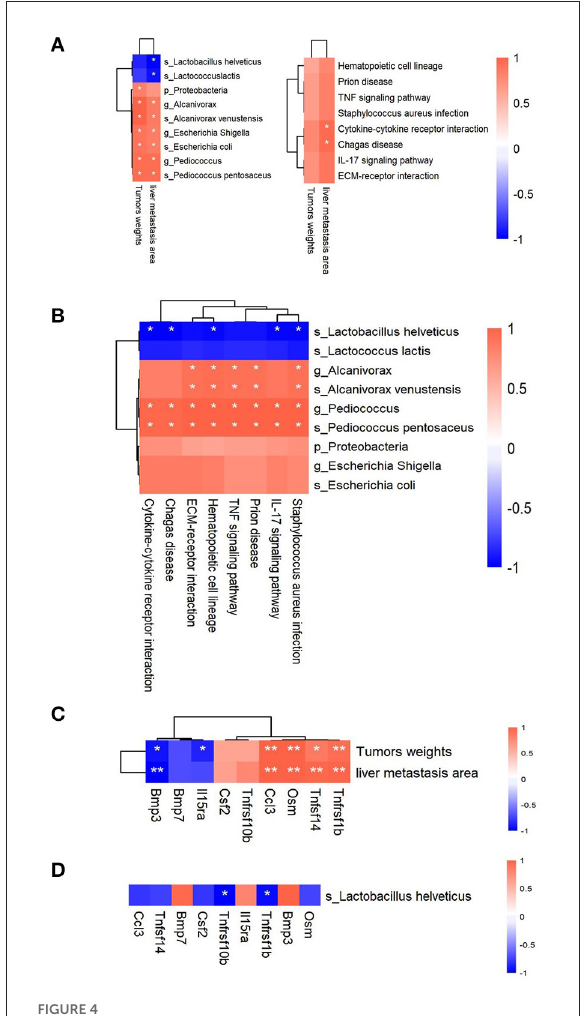
FIGURE4 Correlations among the gut bacteria, signaling pathways, DEGs, and tumor-related parameters. (A) Heatmaps of the Spearman correlations between 2 tumor-related parameters and 9 microbiota taxa (Left) and 8 signaling pathways (Right). (B) Heatmap of the Spearman correlations between 9 microbiota taxa and 8 signaling pathways. (C) Heatmap of the Spearman correlations between 2 tumor-related parameters and 9 DEGs in the Cytokine-Cytokine receptor interaction signal pathway. (D) Heatmap of the Spearman correlations between Lactobacillus helveticus and 9 DEGs in the Cytokine-Cytokine receptor interaction signal pathway. n = 3 per group, *Adjusted P < 0.05; **Adjusted P <